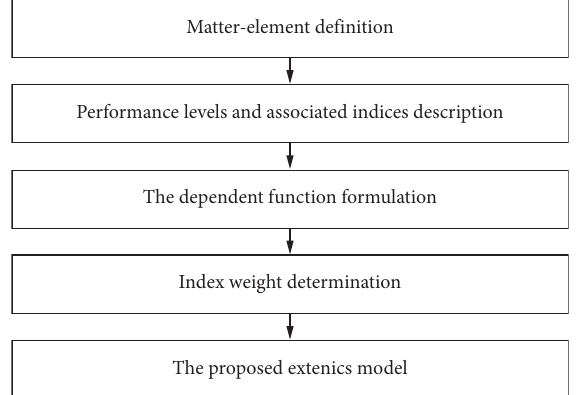
Figure 1: The flowchart of the model